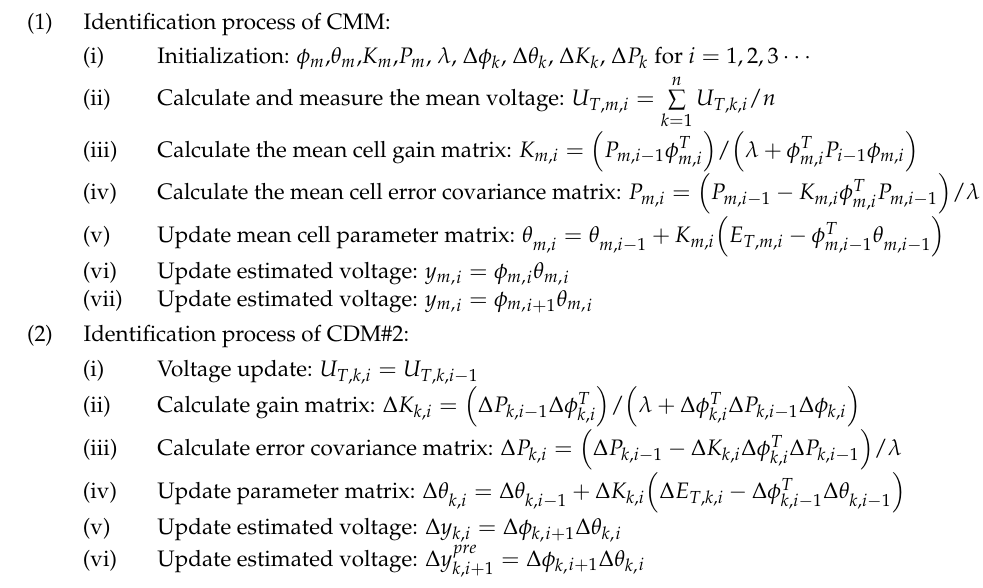
Table 2. MDM Model parameter identification and